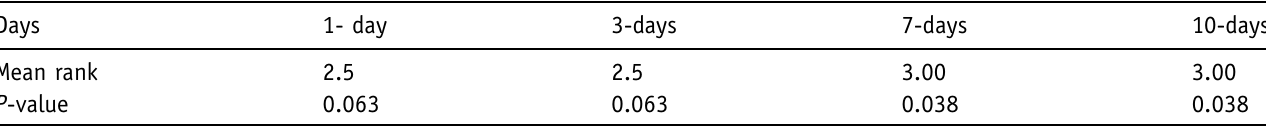
Table I. Wilcoxon Signed Ranks Test for histopathological readings